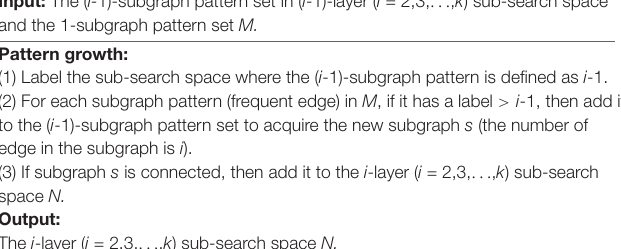
TABLE 3 | Algorithm for pattern